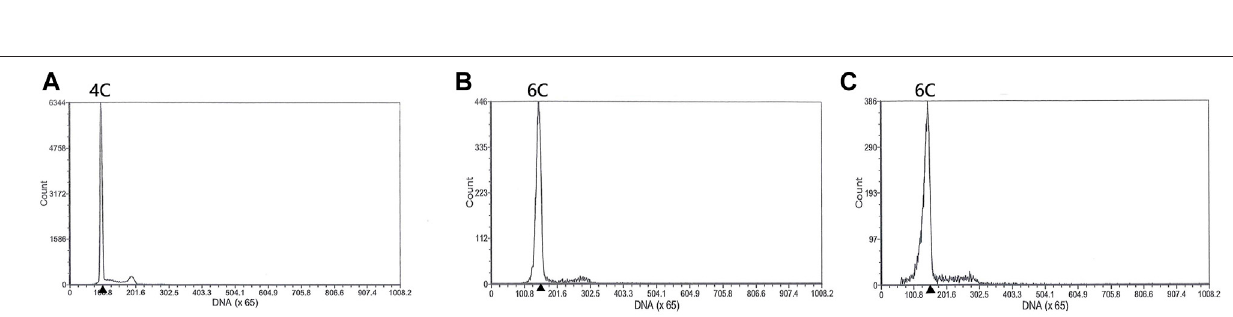
TABLE 2 | Breeding tests of semen from 2nDTCC and 3nDTCC crossing with the eggs of 3nDTCC. Breeding group Fertility rate (%) Hatching rate (%) Survival rate after 3nDTCC( \ ) × 2nDTCC( _ ) Group-A